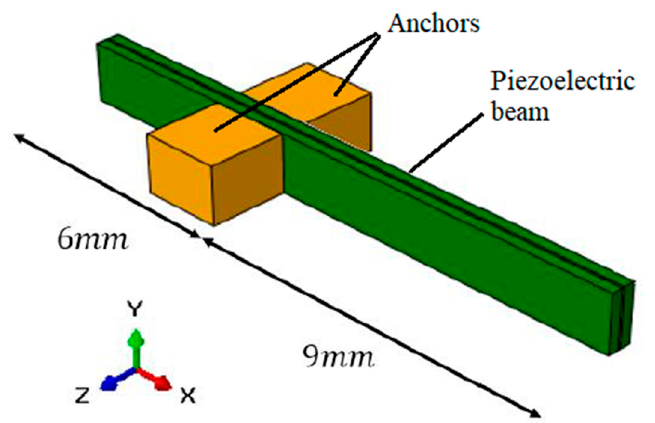
Figure 13. Illustration of the piezoelectric transducer and the anchors.